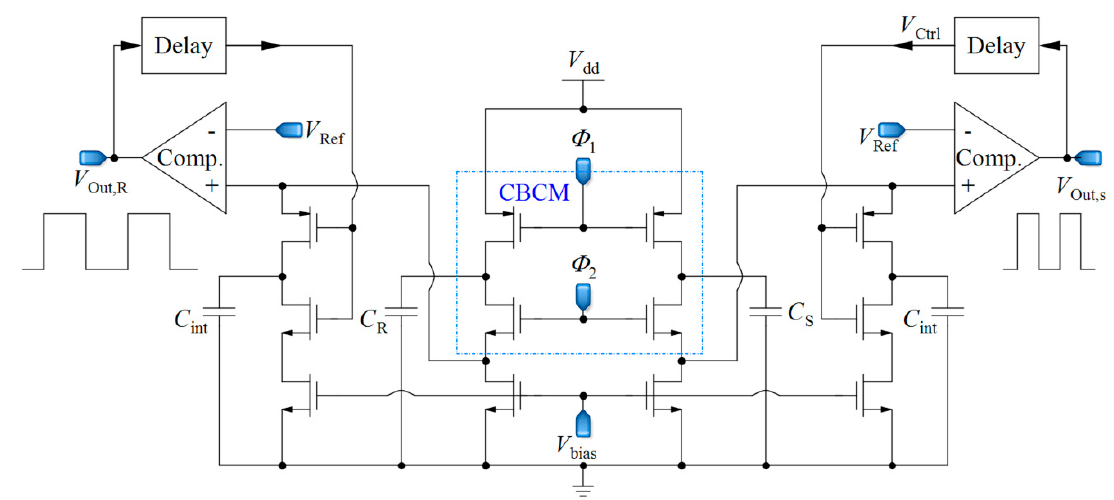
Figure 6. A core-CBCM capacitance-to-frequency converter that integrates all of the exponential CBCM currents in the analog domain and converts them to two frequencies (adapted from [66]).